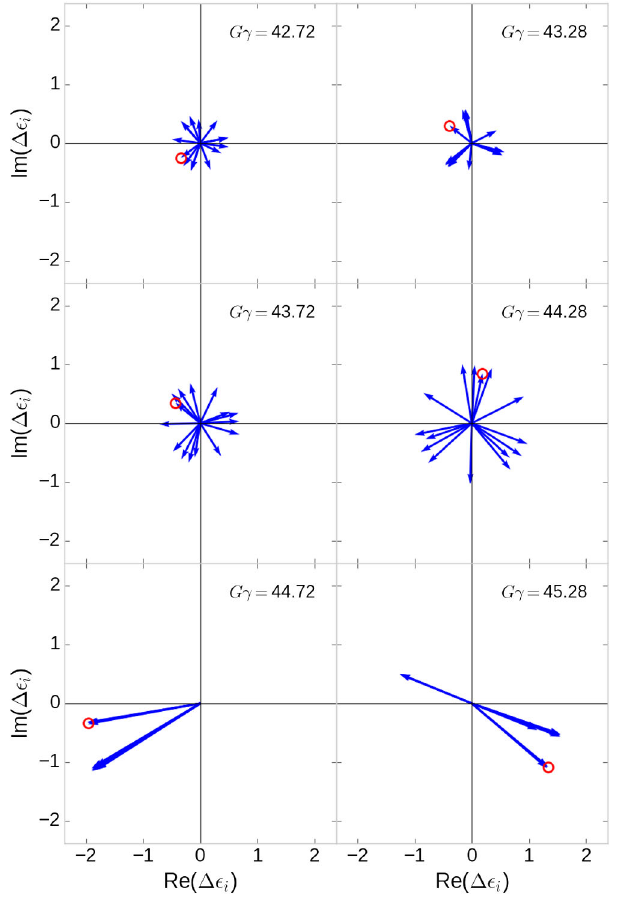
FIG. 1. Resonance response vectors Δ ϵ i ¼ d ϵ =dk i for the last six horizontal resonances crossed by polarized protons during acceleration in the AGS ( G γ increases left to right, top to bottom). The overall phase of each plot is determined by making the horizontal resonance vector (not shown) entirely real. The response of one skew quadrupole (the same one in each plot) is highlighted with a red circle to demonstrate that the phasing of the correction vector for any given quadrupole can change significantly for adjacent resonances.